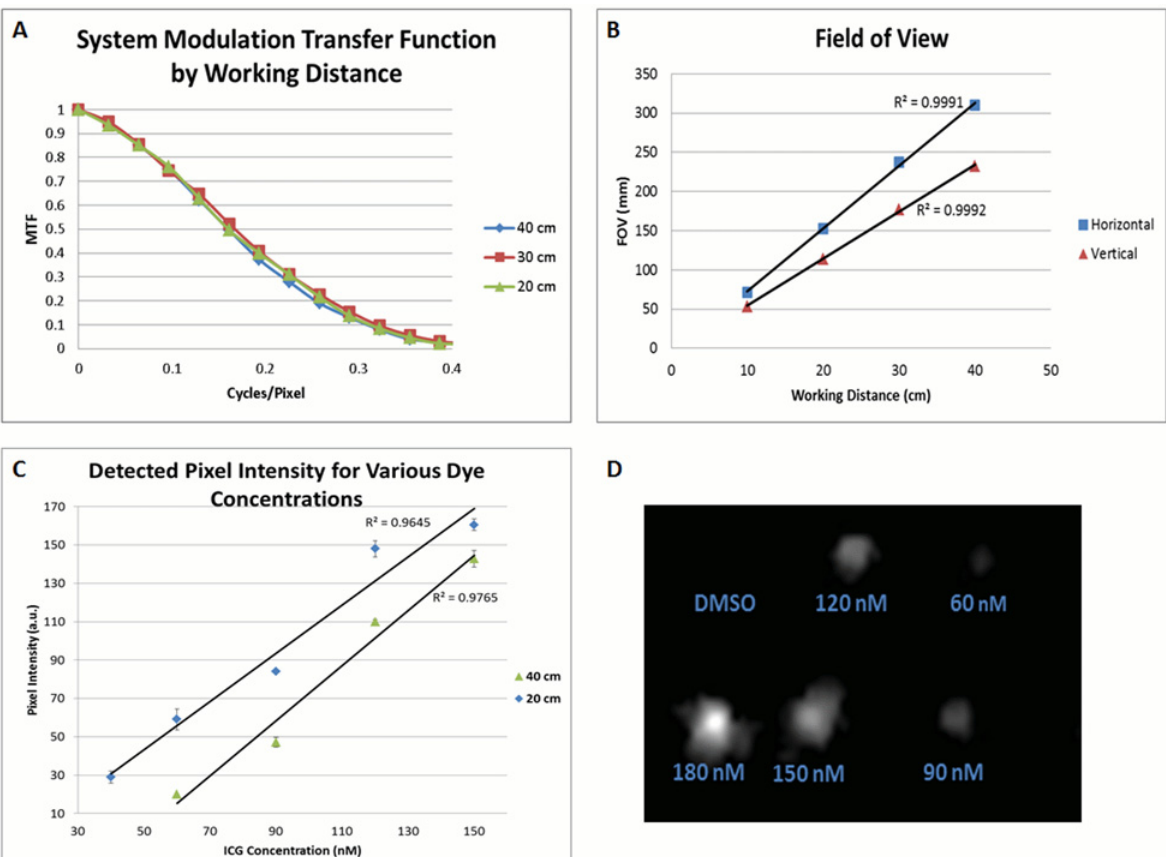
Fig 2. System Characterization. (A) Modulation transfer functions (MTF) for the NIR imaging detector as a function of cycles per pixel. (B) FOV measurements for the NIR imaging detector taken versus working distances of 20, 30, and 40 cm. Vertical and Horizontal FOV measurements were recorded. (C) Pixel intensity for the detected fluorescent emissions from excited solutions of ICG/DMSO of varying ICG concentration, as detected by the NIR imaging detector. The detected fluorescent intensity decreases with increasing working distance. In addition, the intensity of the fluorescence at any working distance increases linearly with dye concentration (R 2 = 0.96). (D) The detected fluorescence from an injection of a serial dilution of ICG/DMSO into 0.5 mm holes cut into the surface of a chicken breast. Imaging was conducted at 40 cm working distance under 785 low pass filtered